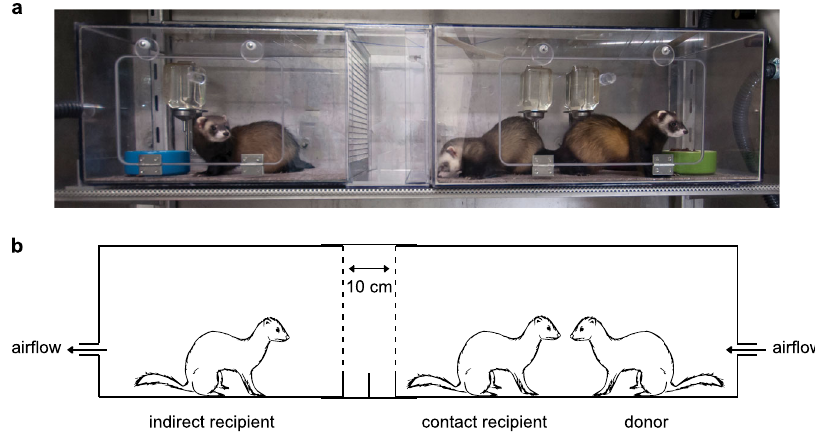
Fig. 1 The ferret transmission experimental set-up. Picture ( a ) and schematic representation ( b ) of one independent experimental set-up to assess direct contact transmission and indirect transmission via the air. One inoculated donor ferret is housed in a cage (right-hand side of the picture). Six hours later, a direct contact ferret is added to the same cage as the donor ferret. The next day, an indirect recipient ferret is placed in an opposite cage (left-hand side of the picture) separated by two steel grids, 10 cm apart, to avoid contact transmission. The direction of the air fl ow (100 L min − 1 ) is indicated by the arrows. The ferret transmission set-ups are placed in class III isolators in a biosafety level 3 + laboratory.